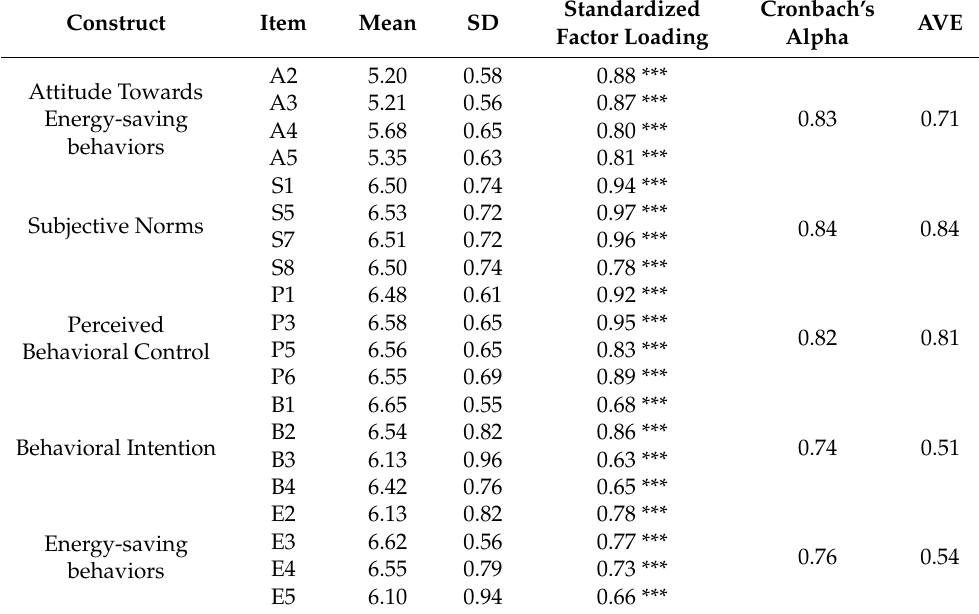
Table 2. Results of confirmatory factor analysis.